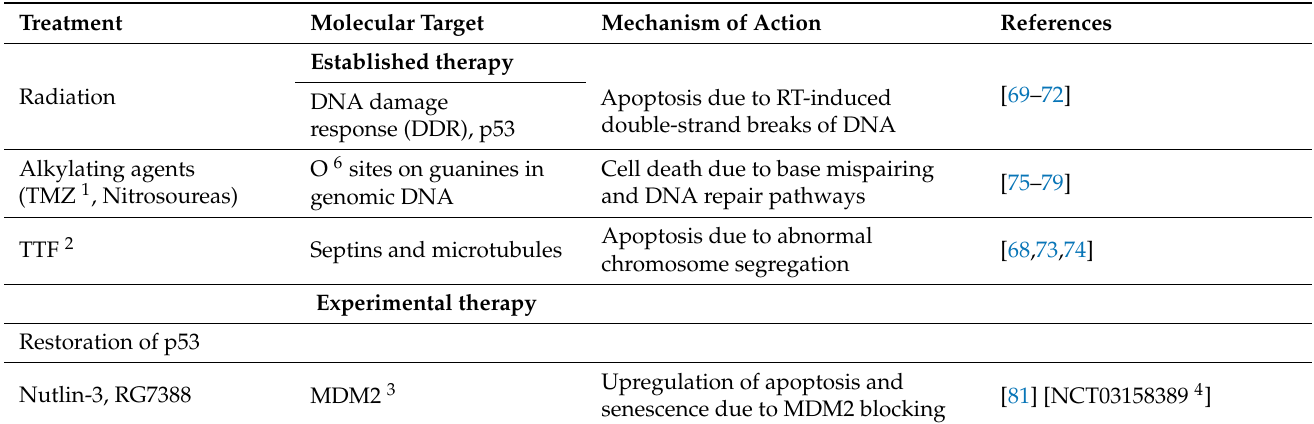
Table 1. Established and experimental therapeutics targeting cell cycle and apoptosis machinery in